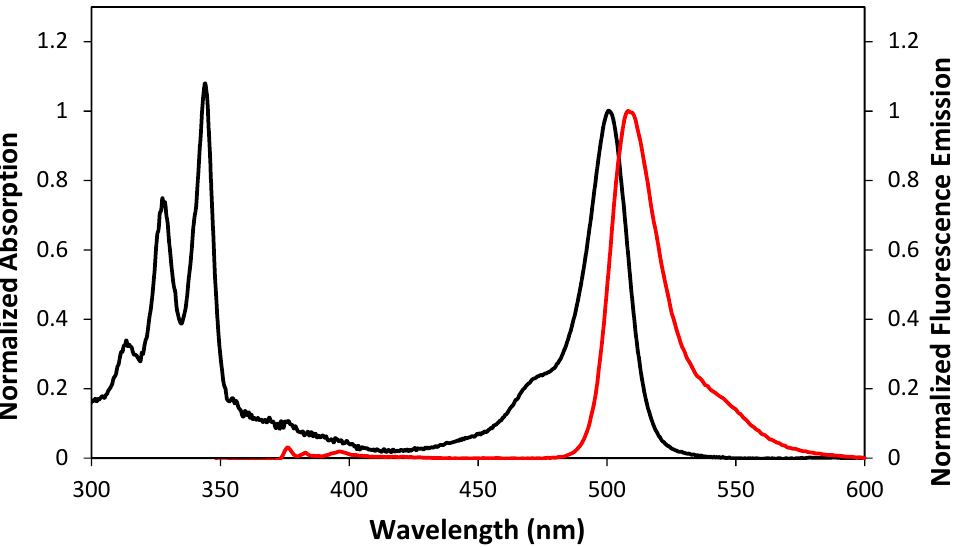
Figure 3. Absorption (black) and emission (red) spectra for compound 7 .